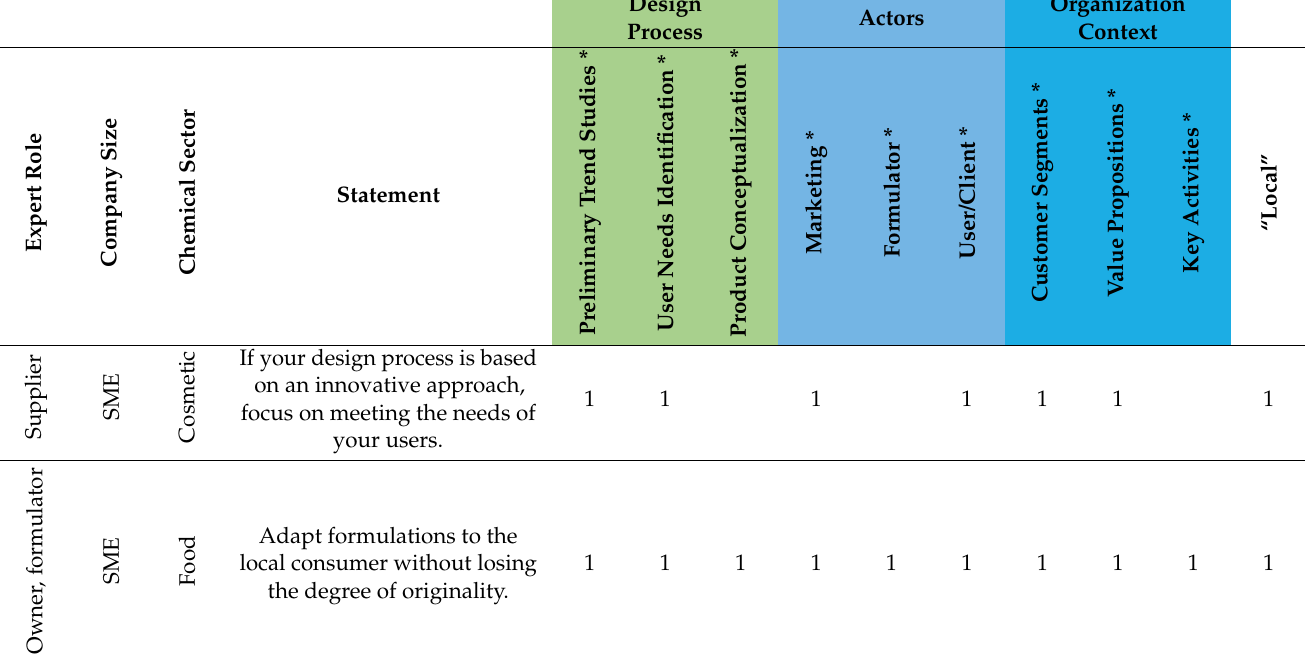
Table 6. Recommendations for the case of